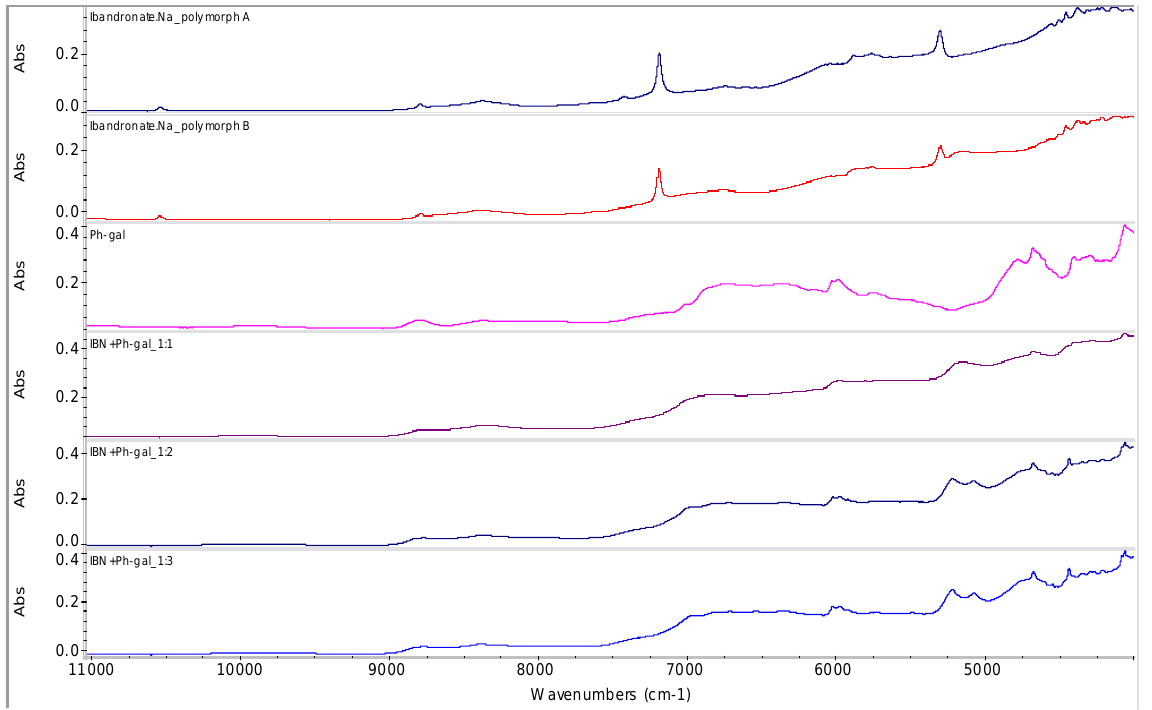
Figure 7. NIR spectra of ibandronate (IBN) monosodium salt forms A and B, phenyl- β - D - galactopyranoside (Ph-gal) and spectra of potential co-crystals of IBN+Ph-gal in ratios 1:1, 1:2 and 1:3 prepared by evaporation at ambient temperature (samples 1 - 3